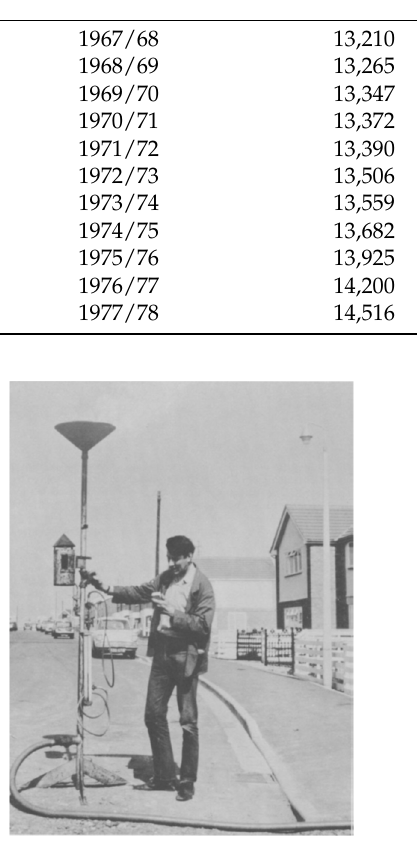
Figure 5. Town-gas-to-natural-gas transition field work in a Midlands town in England [50].